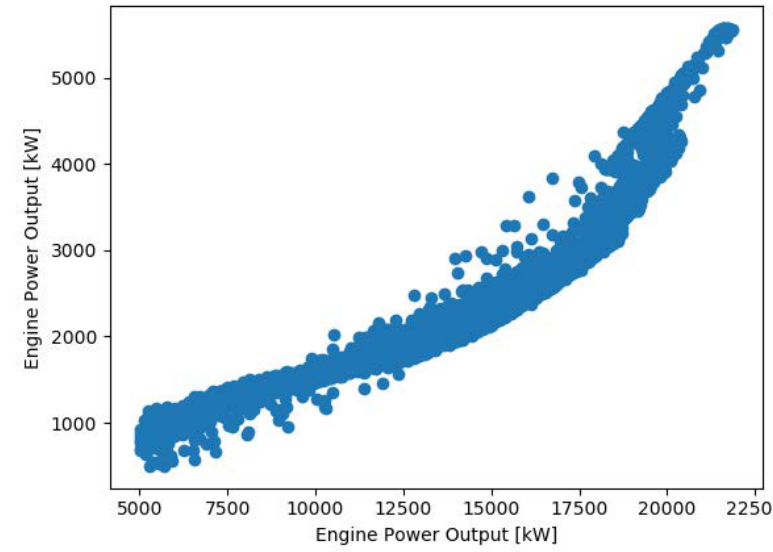
Figure A2. Scatter plot, Main engine power versus turbocharger speed